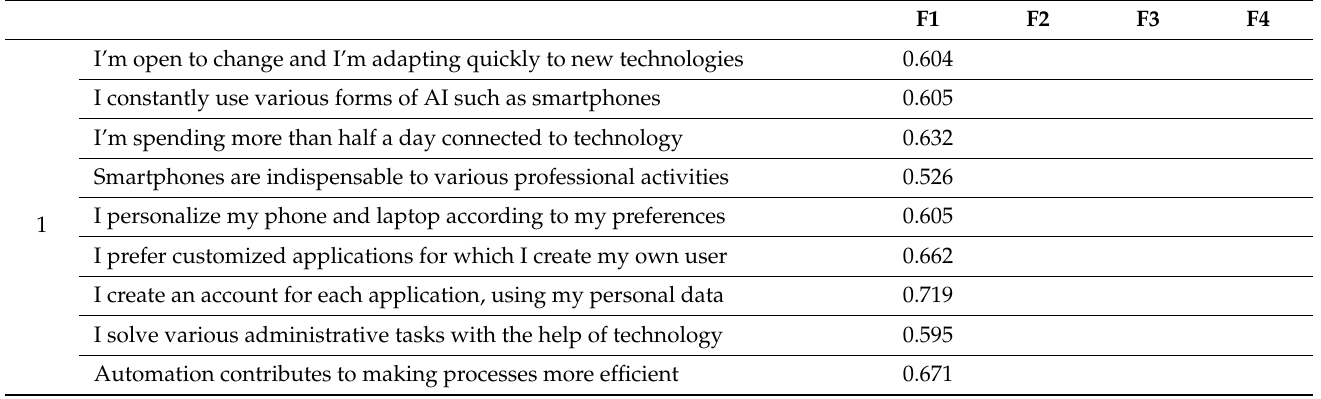
Table 1. Results of the factor